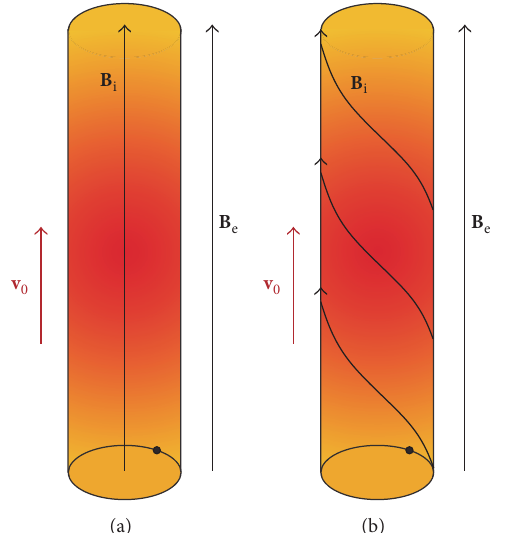
Figure 1: Equilibrium magnetic fields of a soft X-ray solar jet in an untwisted flux tube (a) and in a weakly twisted flux tube (b).